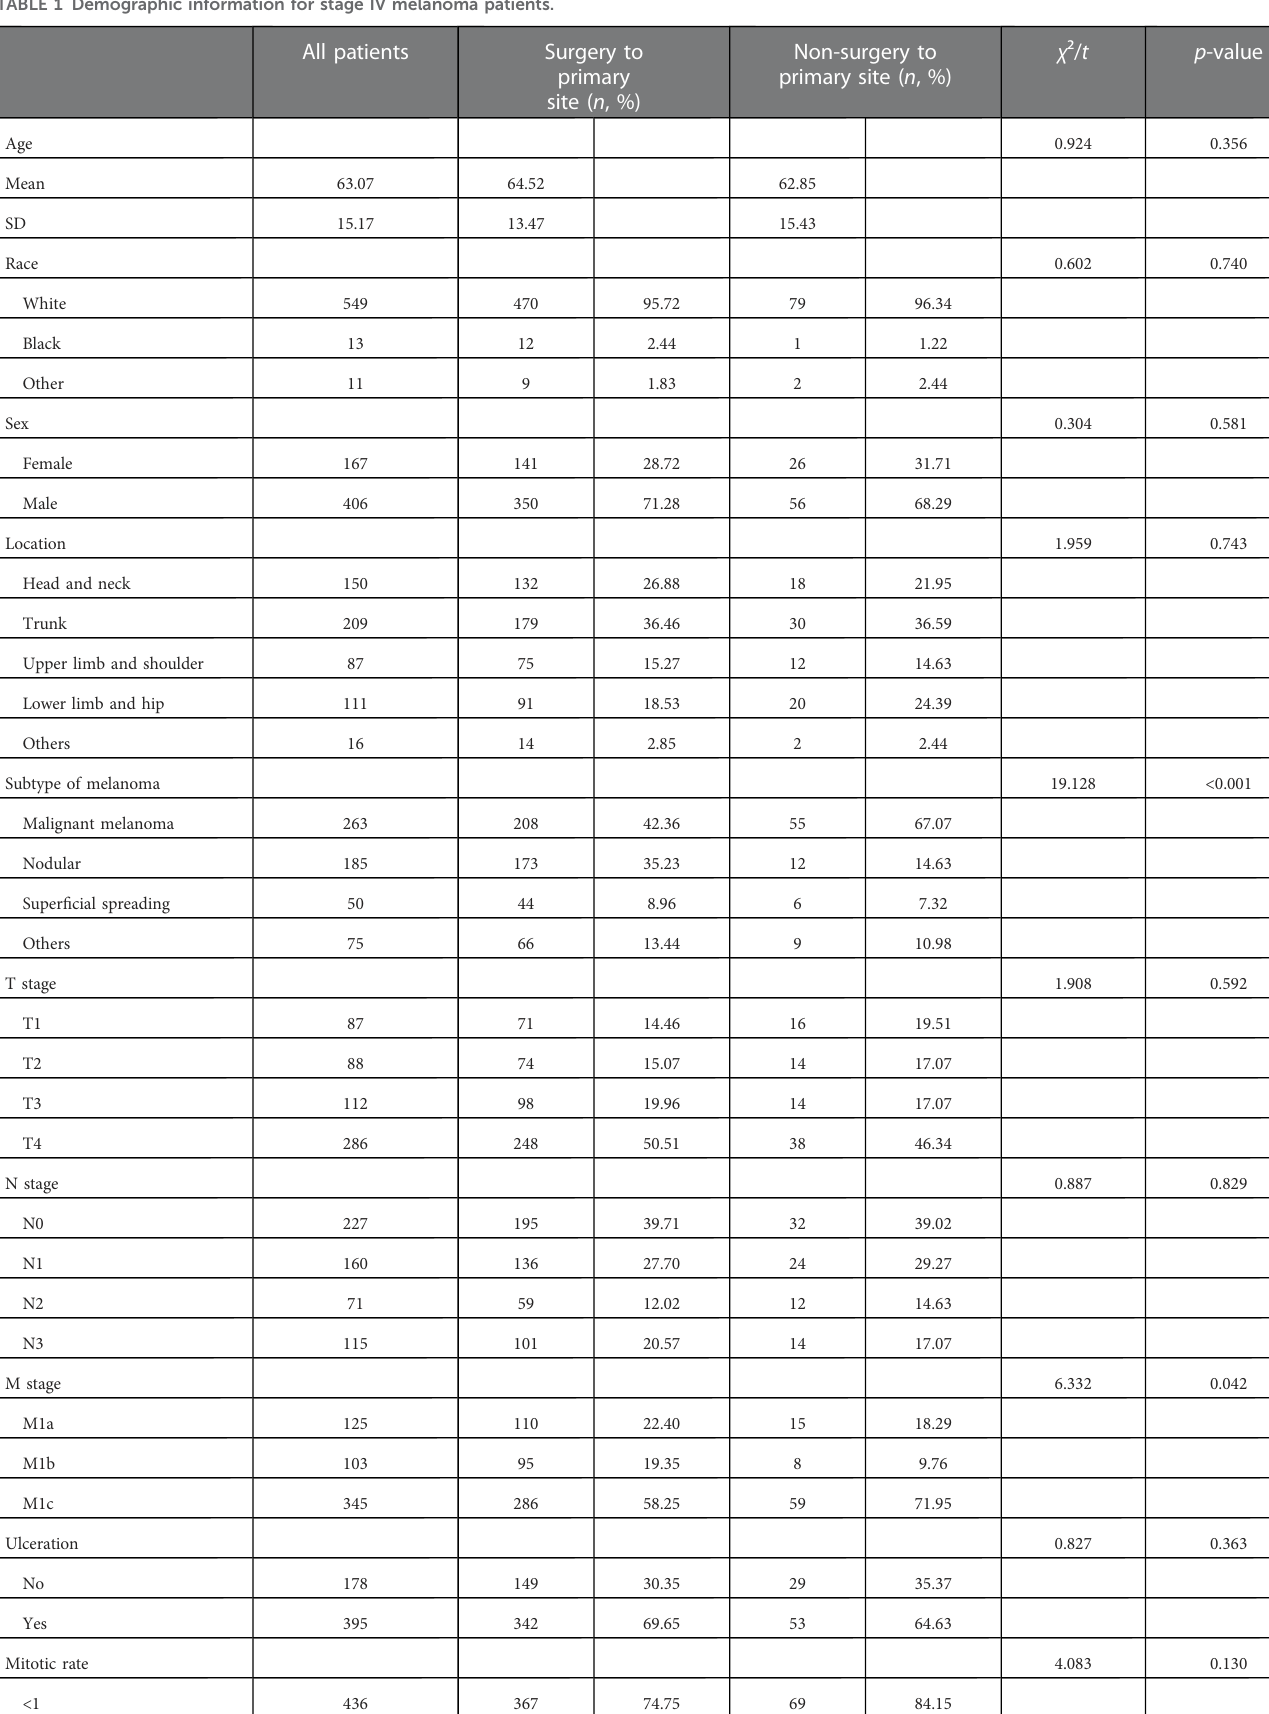
TABLE 1 Demographic information for stage IV melanoma patients.